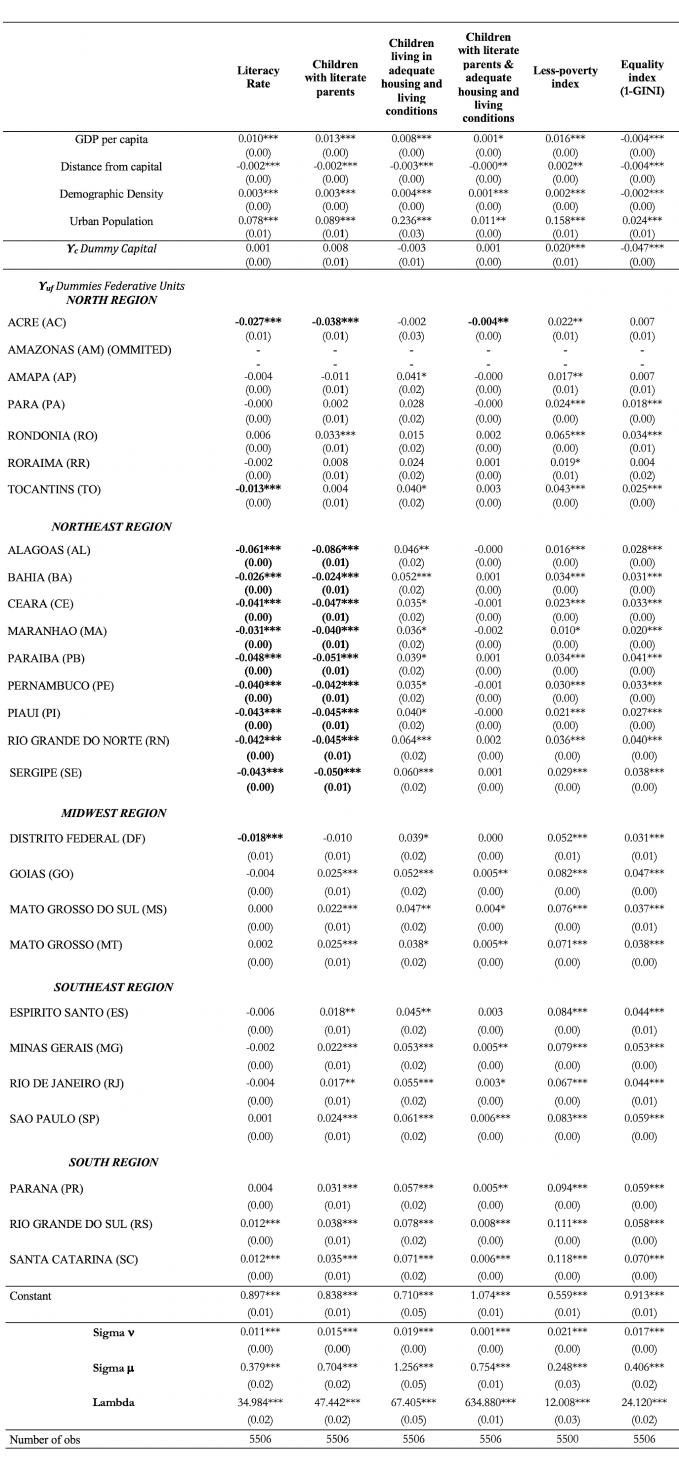
Table 16: Social Regressions MODEL